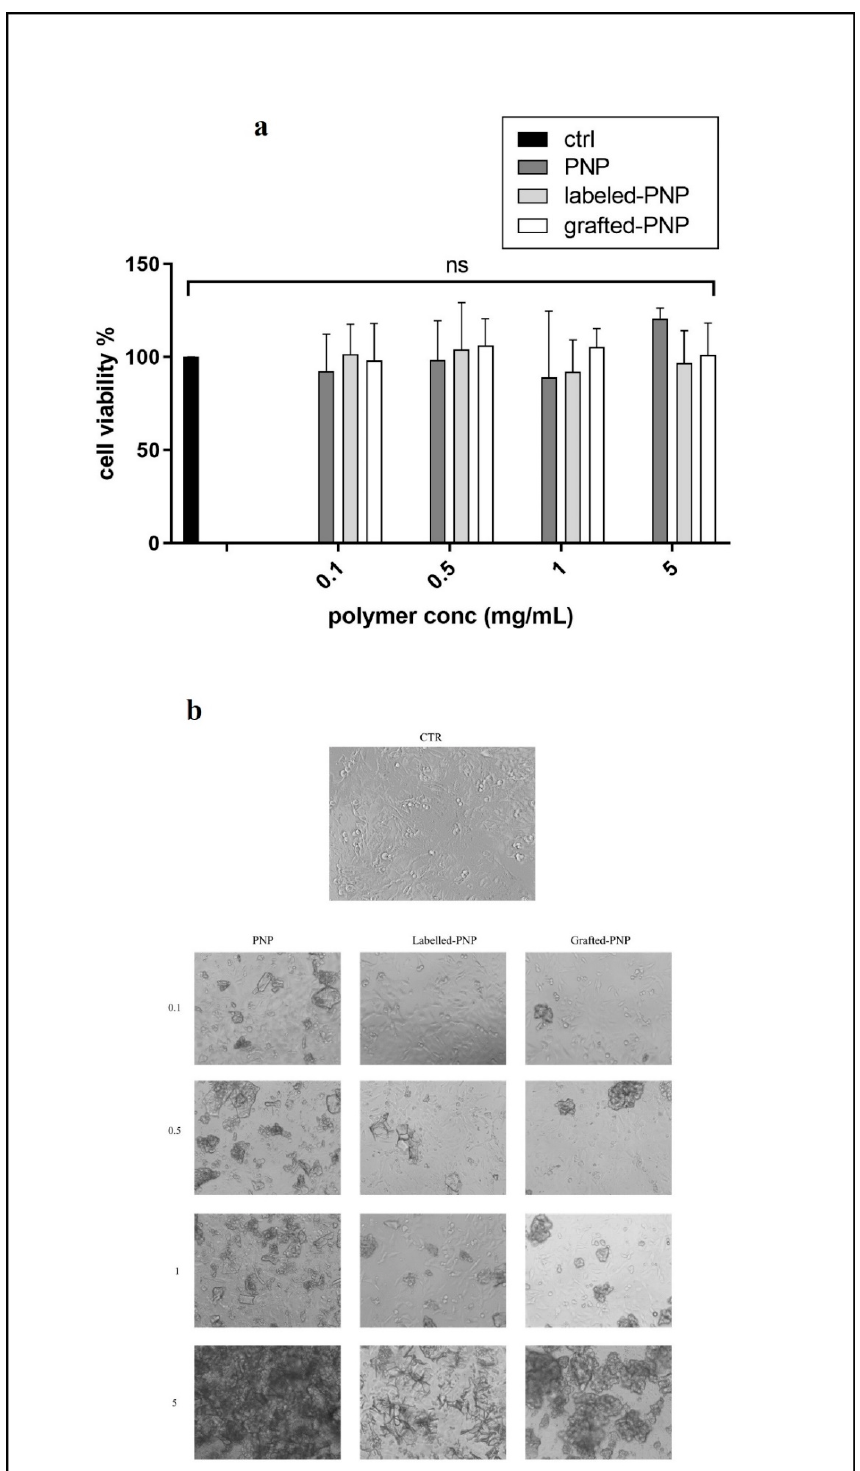
Figure 7. ( a ) Cell viability after exposure for 24 h of normal olfactory ensheathing cells (OECs) to PNPs, loded-PNPs and grafted-PNPs at different concentrations, ns means not significant statistically ( b ) Qualitative analysis by phase-contrast microscopy of representative fields of OECs, both as control and loaded to PNP, loaded-PNP and grafted-PNP at different concentrations (0.1, 0.5, 0.1 and 0.5